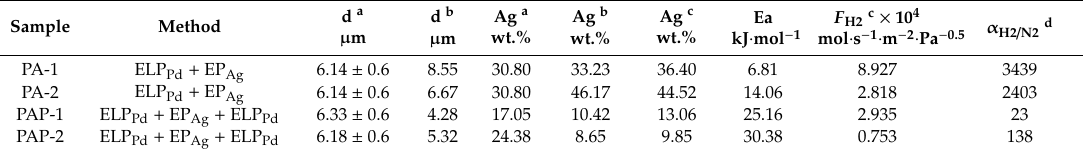
Table 1. Performance data of the Pd-Ag alloy membranes investigated in this